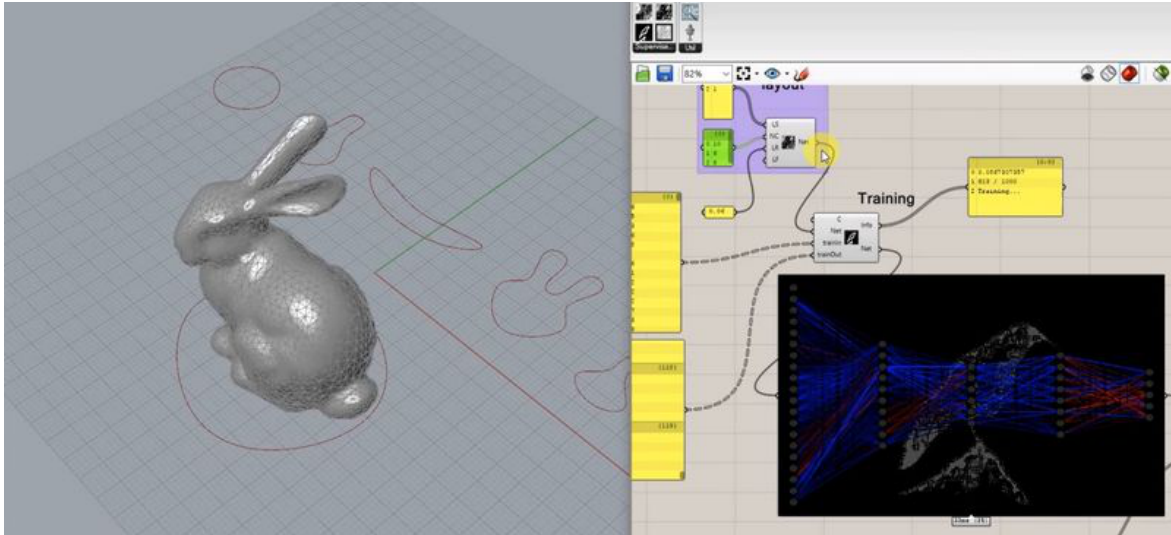
Figure 8. The Crow Library. The interface of the Crow library in action, with the graphical language User Interface (UI) on the right and the 3D shapes outputted by the NN on the left. From: Benjamin Felbrich,